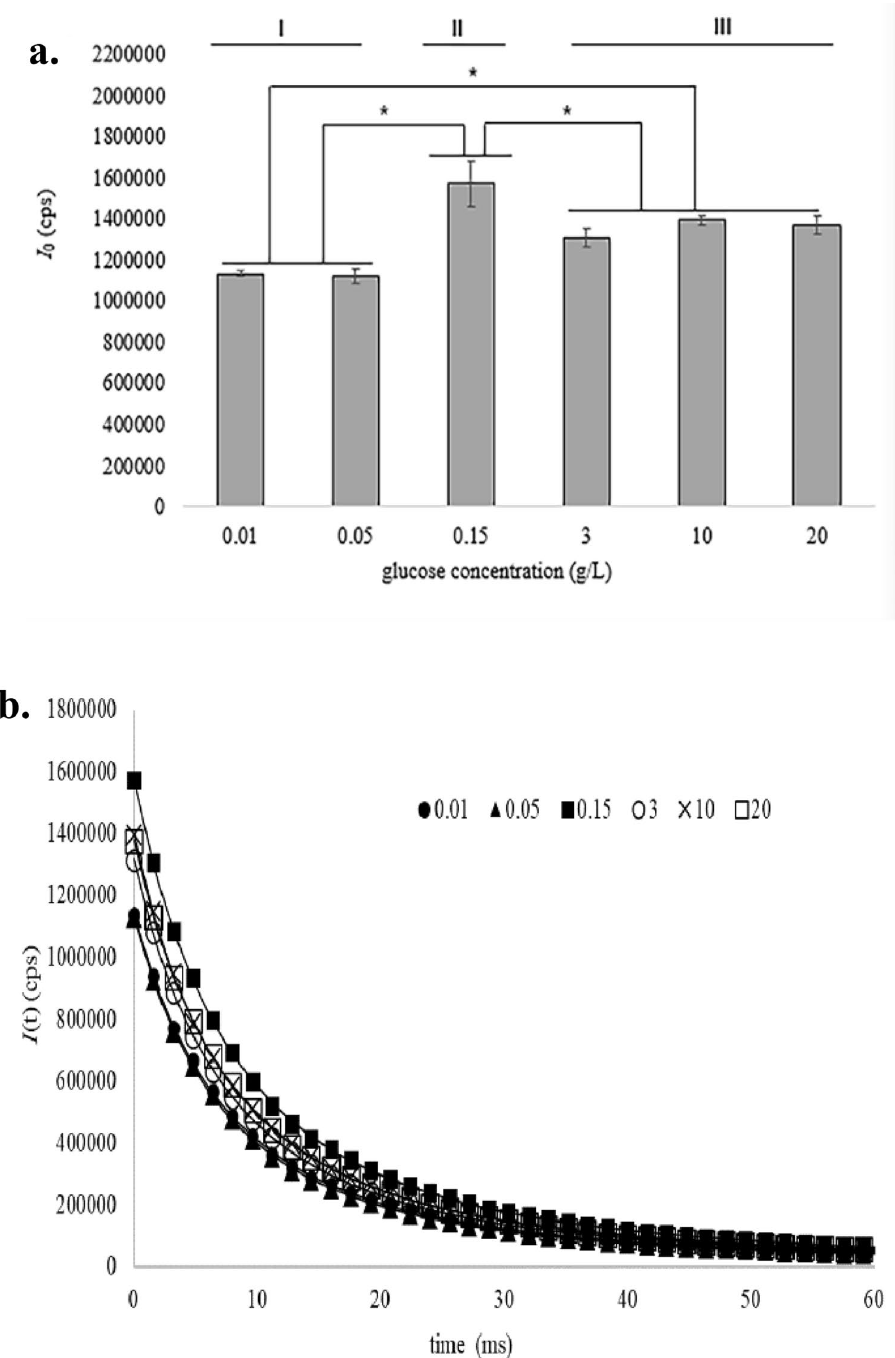
Figure 1. I 0 ( a ) and kinetics curves ( b ) of DL emission from S. cerevisiae cells under 0.01, 0.05, 0.15, 3, 10 and 20 g/L glucose for 3 h. Statistical analyses were performed using one-way ANOVA followed by Tukey’s test. * p < 0.05 indicated statistically significant differences of I 0 among the yeast cells cultured in different glucose concentrations. Values represent the mean ± SD of three independent experiments. Group categorization was performed by K-means clustering, group I included cells in 0.01 and 0.05 g/L glucose, group II included cells in 0.15 g/L glucose, group III include cells in 3, 10 and 20 g/L